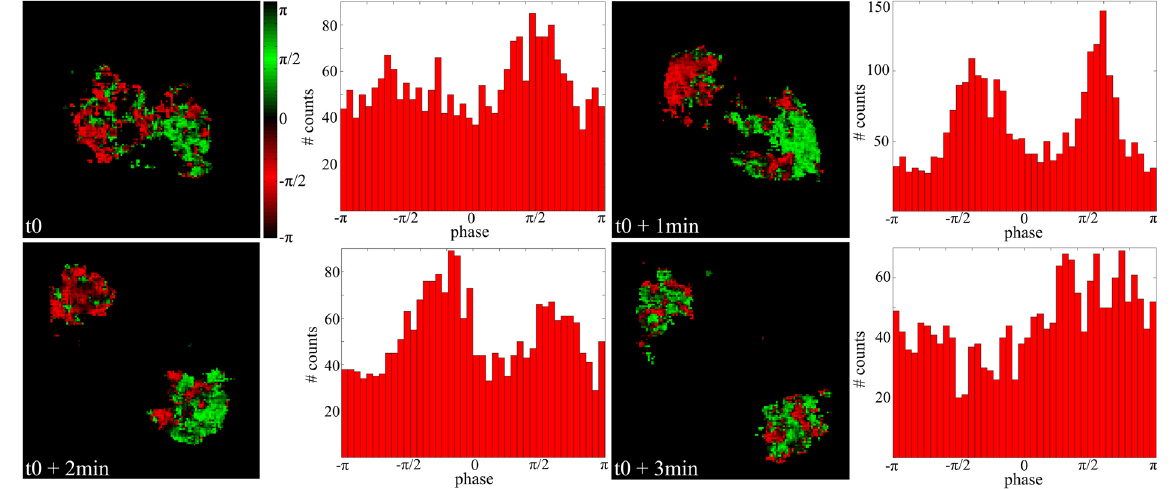
Figure 3. Image and histogram of the phase of the SHG signal generated in the spindles during mitosis. Field of view: 29 × 29 µ m 2